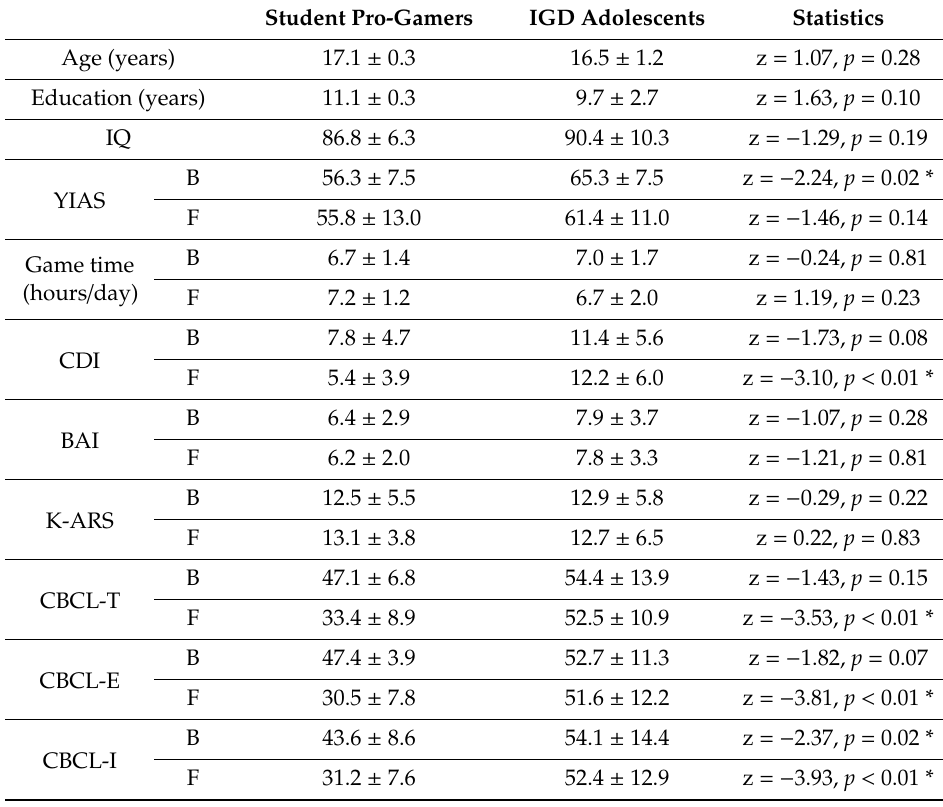
Table 1. Demographic and psychological